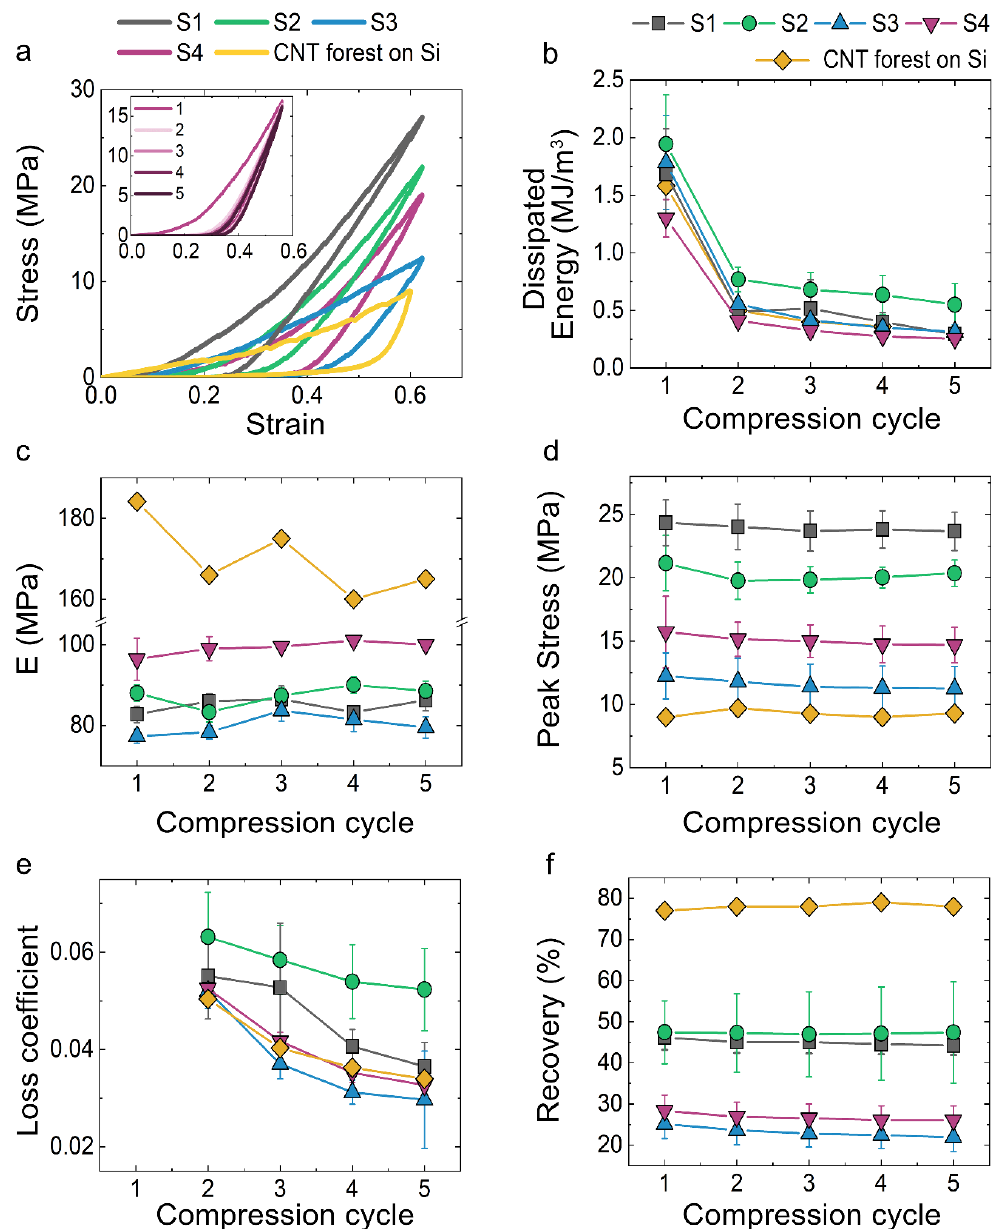
Figure 4. ( a ) Stress-strain curves for CNT forests grown on all substrates; five consecutive compression cycle stress-strain data for S4 (inset); ( b ) dissipated energy; ( c ) unloading modulus; ( d ) peak stress; ( e ) loss coefficient; and ( f ) recovery percentage for CNT forests grown on all substrates; ( b – f ) account for five consecutive compression cycles on each sample.